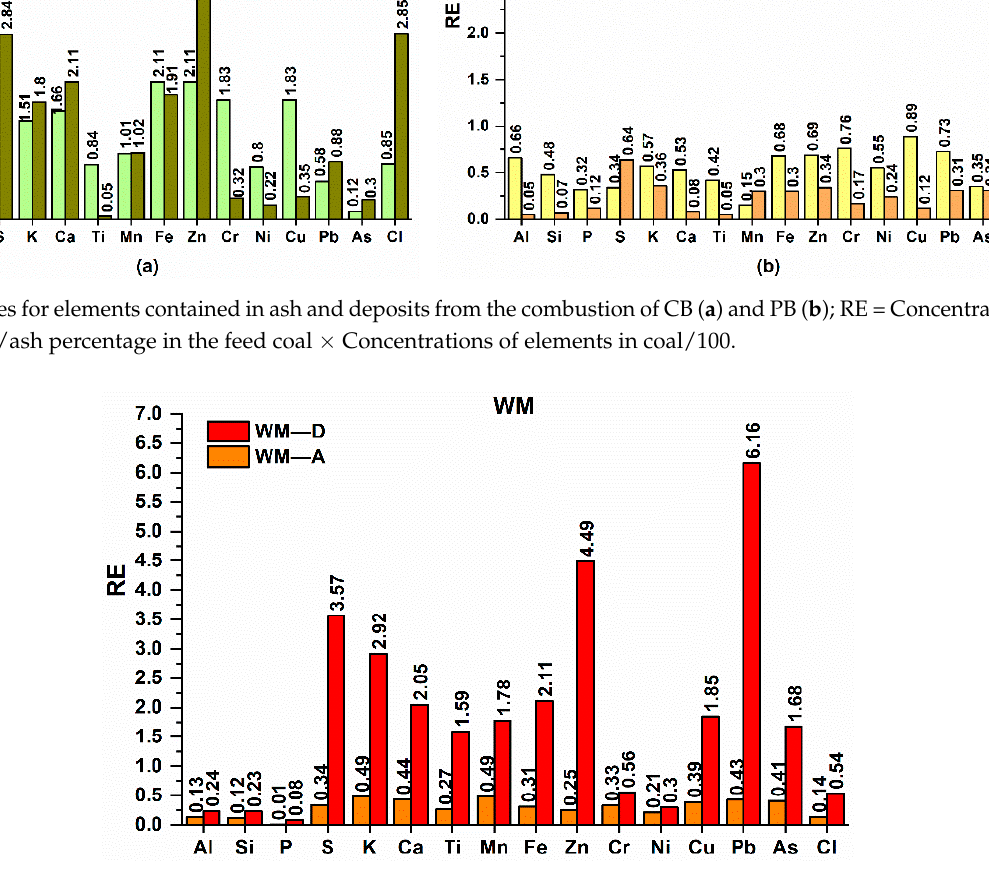
Figure 9. RE values for elements contained in ash and deposits from the combustion of WM. Table 10. Comparison of elements characterised by the RE value according to the classification of Meij [83].